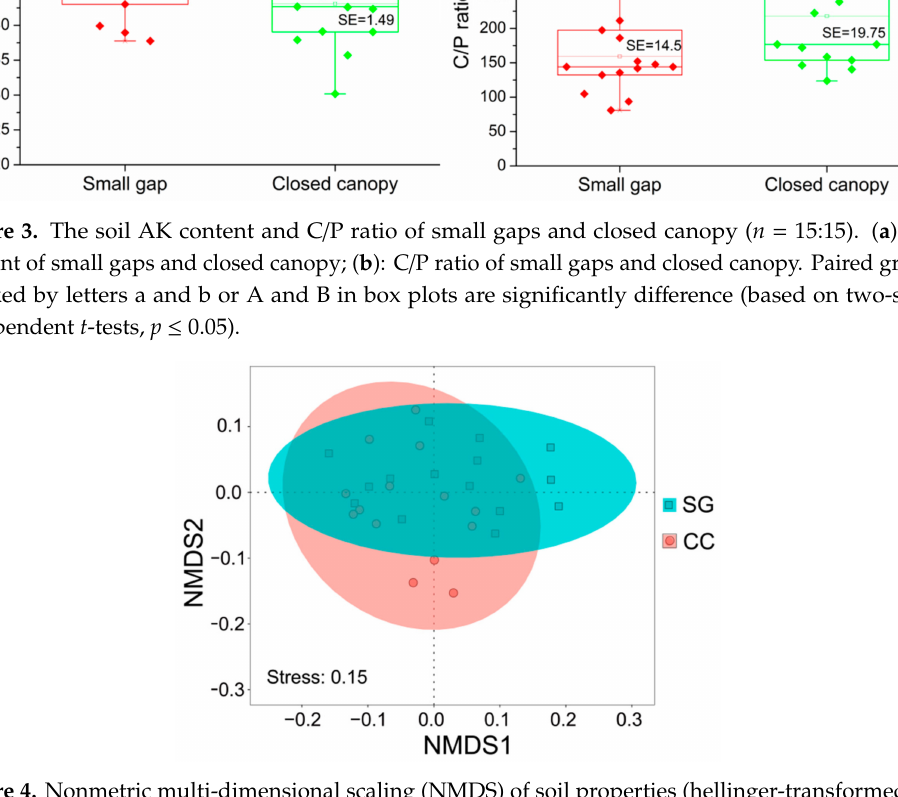
Figure 4. Nonmetric multi-dimensional scaling (NMDS) of soil properties (hellinger-transformed soil property data; distance = “bary”). SG: small gaps ( n = 15); CC: closed canopy ( n =